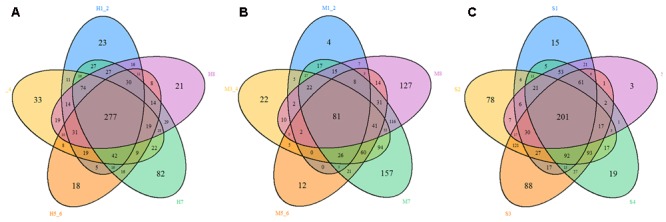
Venn diagram. The Venn diagrams show the numbers of OTUs (97% sequence identity) that were shared or not shared by HMD, MMD, and SMD individuals, respectively, depending on overlaps. For this presentation, two individuals had to be combined (e.g., H1_2) thereby reflecting the number of OTUs shared by both individuals. (A) The number of OTUs shared by HMD. (B) The number of OTUs shared by MMD. (C) The number of OTUs shared by SMD.